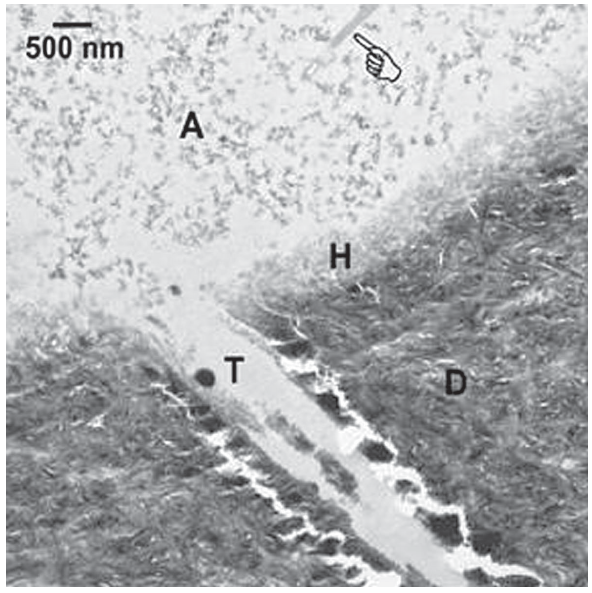
FIGURE 3 - TEM of the interface of ABF to sound dentin. A thin hybrid layer (H) and a resin tag (T) are seen. A=adhesive rein, D=sound dentin, Pointer=sodium fluoride